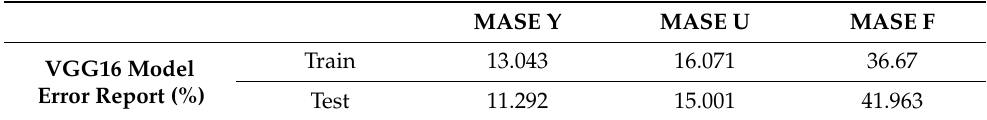
Table 9. VGG16 error report for training and testing data after the HP